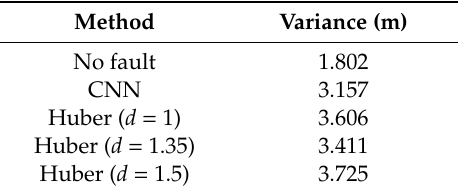
Table 4. Variance of position error corresponding to abrupt